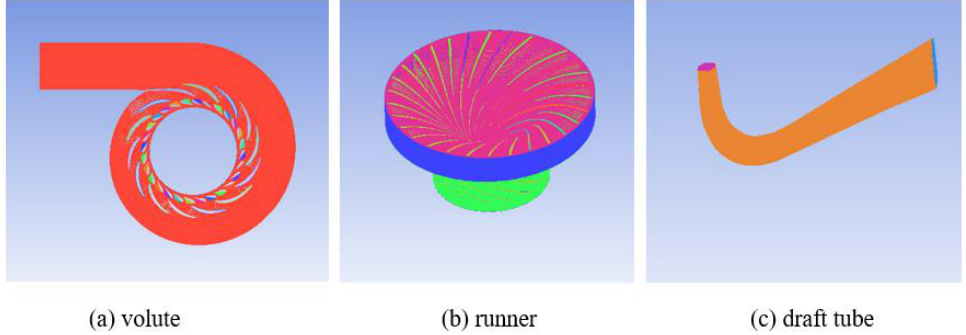
Figure 3. Mesh of computational domain. Table 1. Meshing and Y+ values.